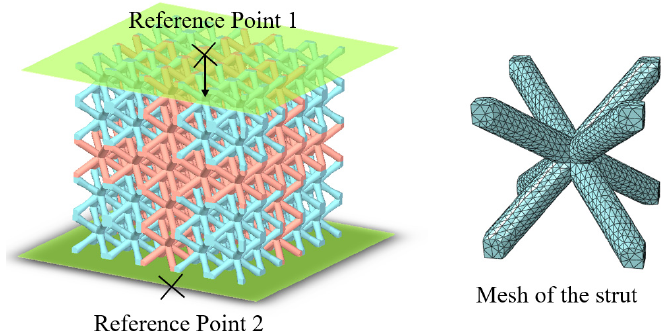
Table 3. Material parameters of the parent material 316 L stainless steel [29].